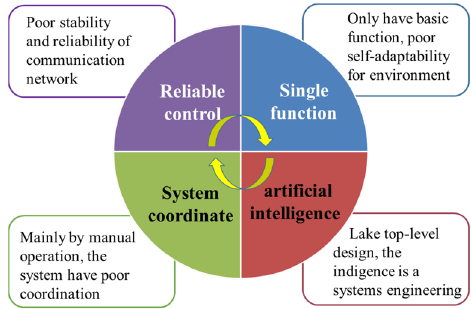
Fig. 9 Intelligent longwall mining key technical problems